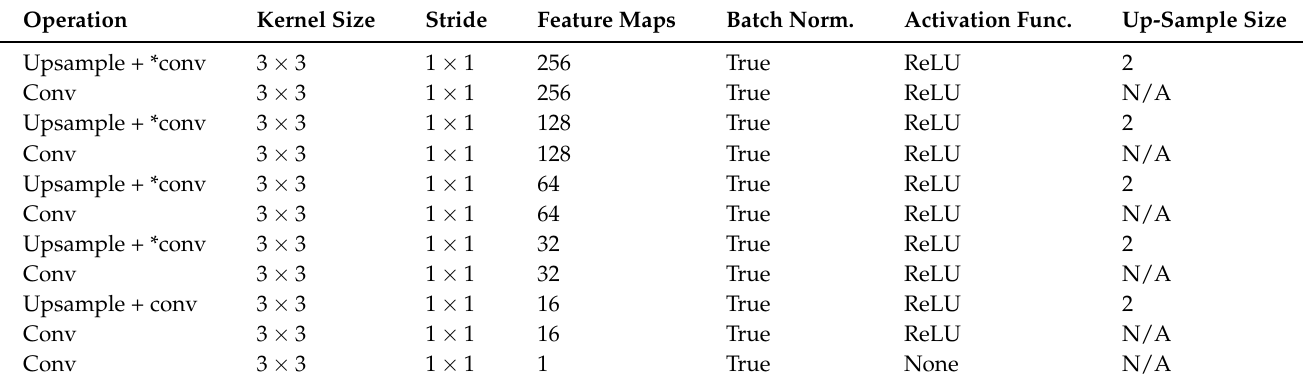
Table 4. Architecture of UNet’s Decoder.